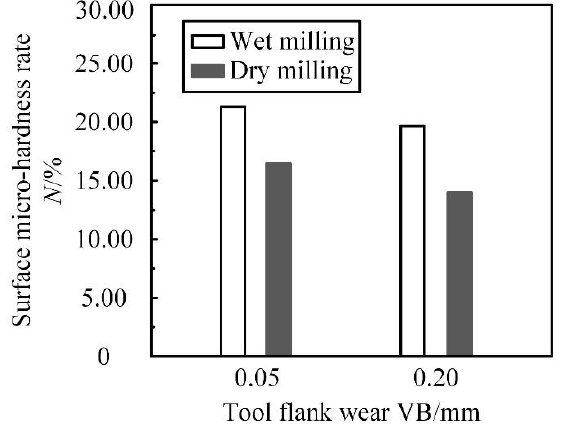
Figure 7. Surface microhardness rate distribution after different cooling conditions.